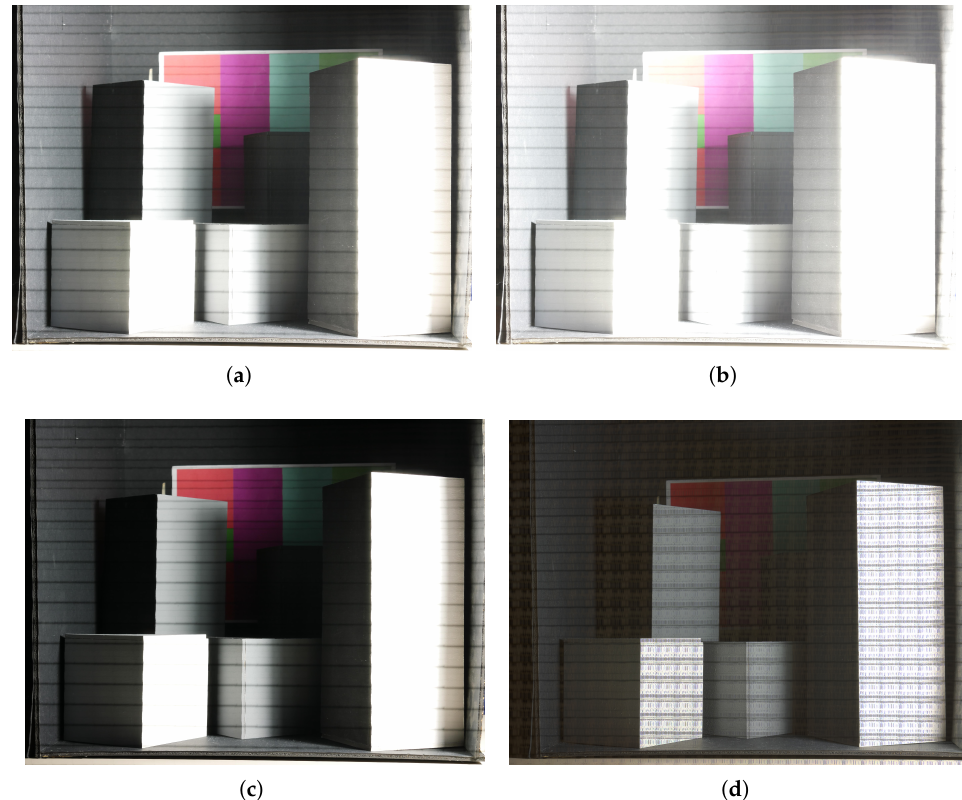
Figure 7. ( a – c ) reconstruction of scene at EV 0, 2, − 2; ( d ) noise produced by direct light on the grid.